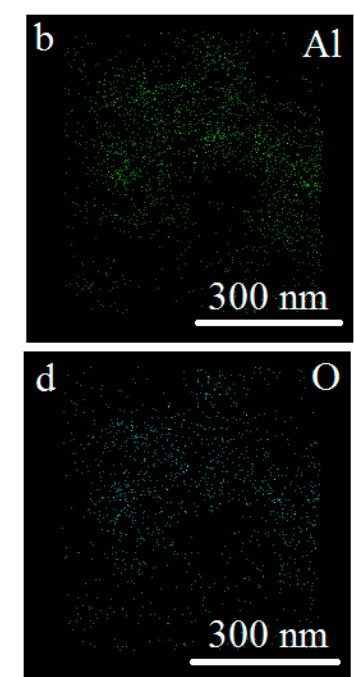
Figure 6. XRD pattern of the nanoscale structures obtained through the water oxidation of Al/Ag nanoparticles at 80% RH at 60 ° С (sample 2).